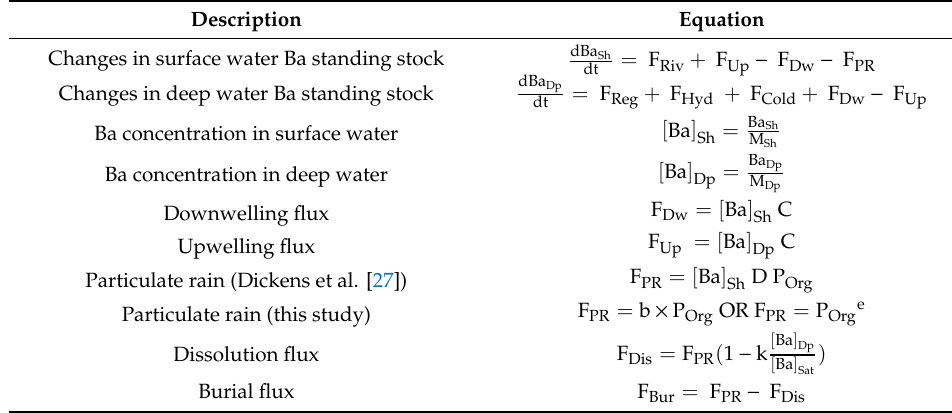
Table 1. Flux equations to describe the marine Ba cycle from Dickens et al. [27] with changes made to the formulation of the particulate rain of Ba flux (F PR ). Variables defined in Table 2.